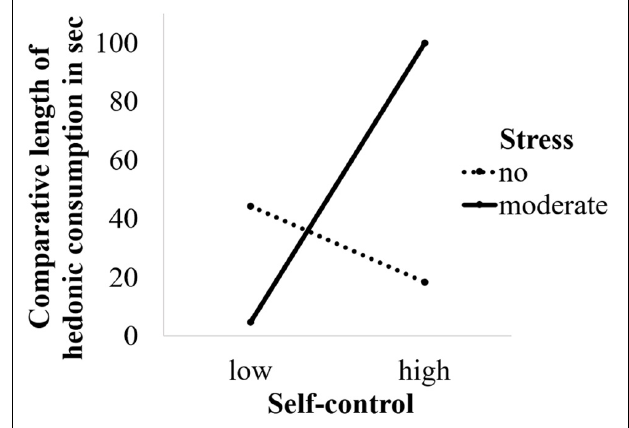
FIGURE 3 | Effects of stress and self-control on comparative viewing time (hedonic video viewing time – neutral video viewing